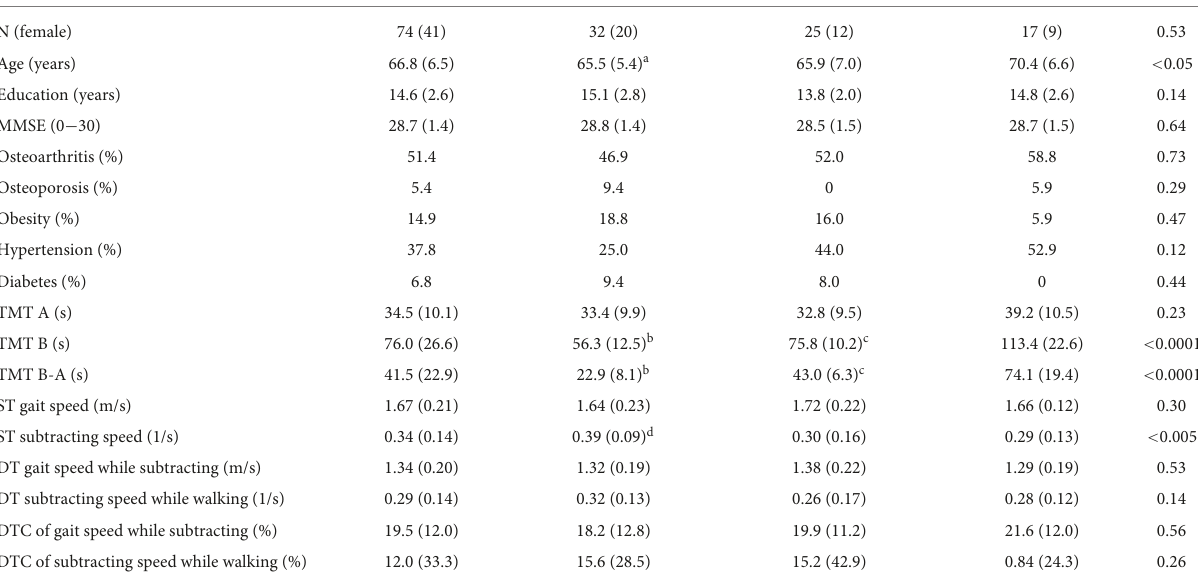
TABLE 1 Demographic and clinical parameters of the groups. Whole cohort (SD)